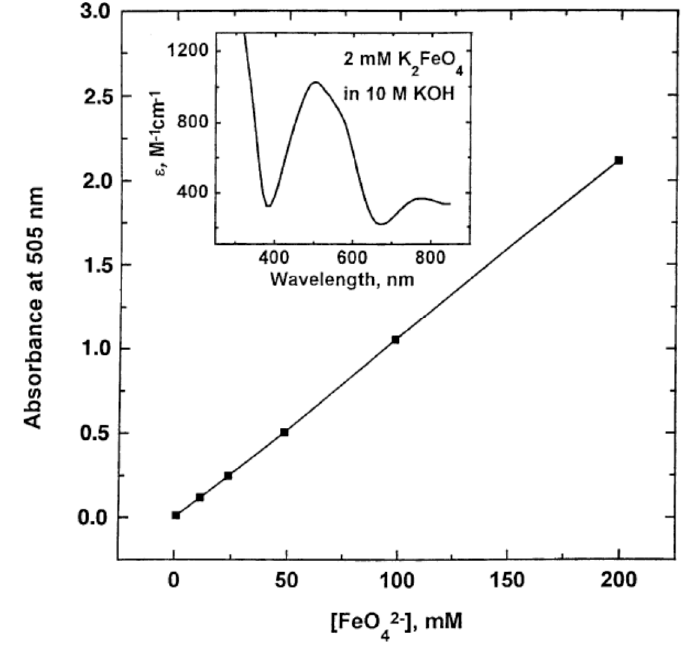
Figure 4. A visible spectrum of K 2 FeO 4 in alkaline solution showing the 505 nm peak [24].